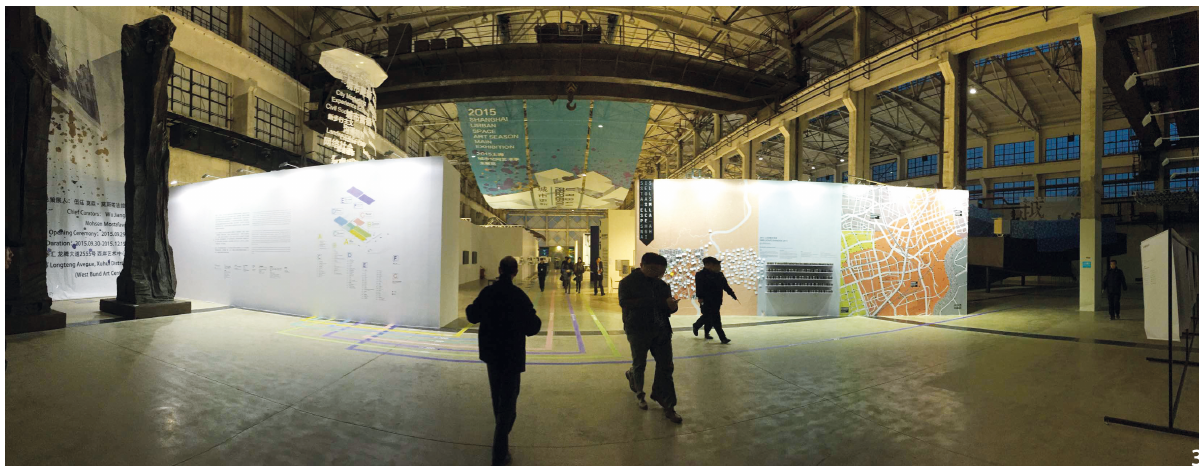
Figure 3 West Bund Art Centre. (Source: the author,